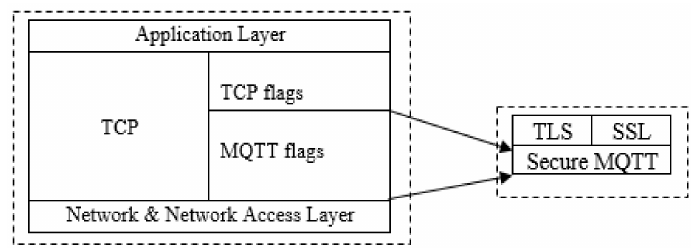
Figure 5. The secure MQTT